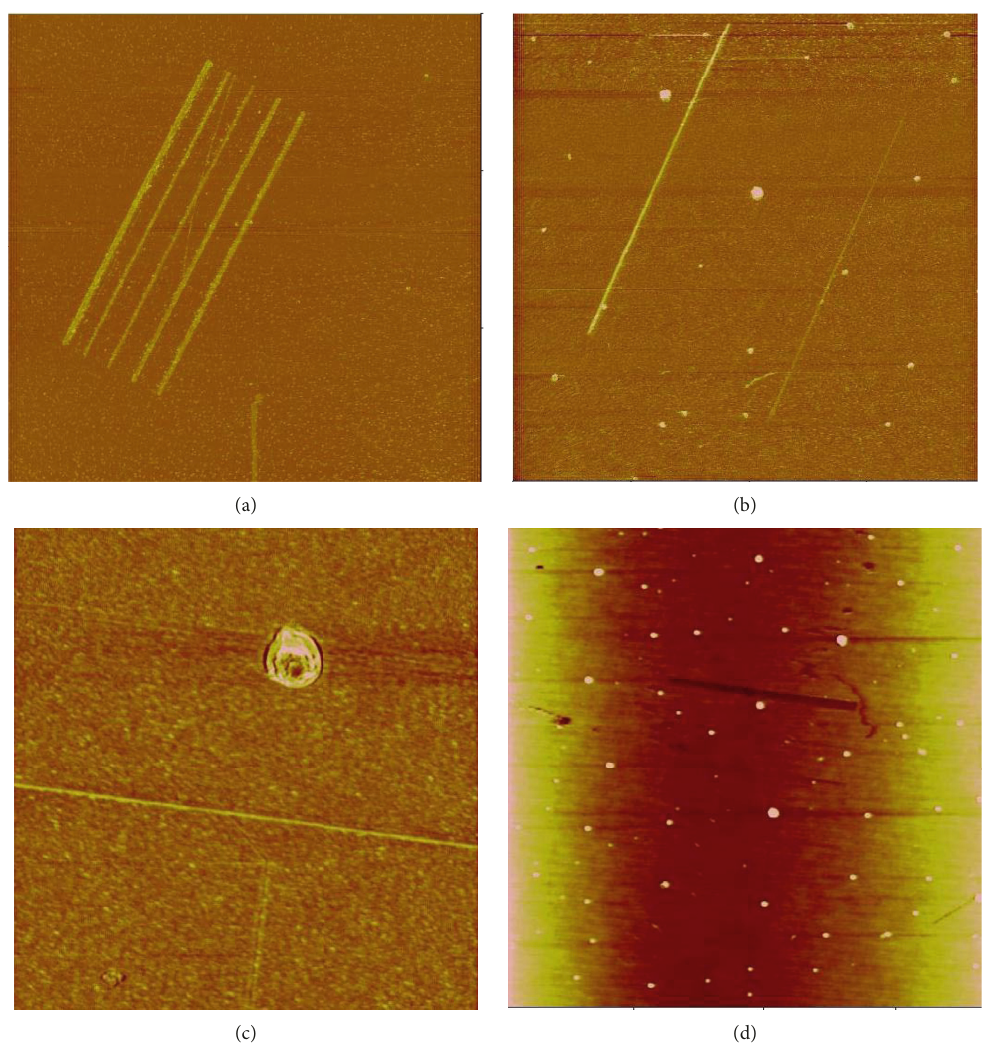
Figure 4: Friction force microscopy image of patterns produced by shaving the poly(ethylene glycol)-silane monolayer on titanium oxide: (a) different-sized patterns on the same sample (image size 20 × 20 μ m 2 , z range 0-1 V); (b) 150nm shaved part (image size 15 × 15 μ m 2 , z range 0–0.5 V); (c) 50nm shaved part (image size 5 × 5 μ m 2 ); (d) 35 × 35 μ m 2 topographic images of the scratches in